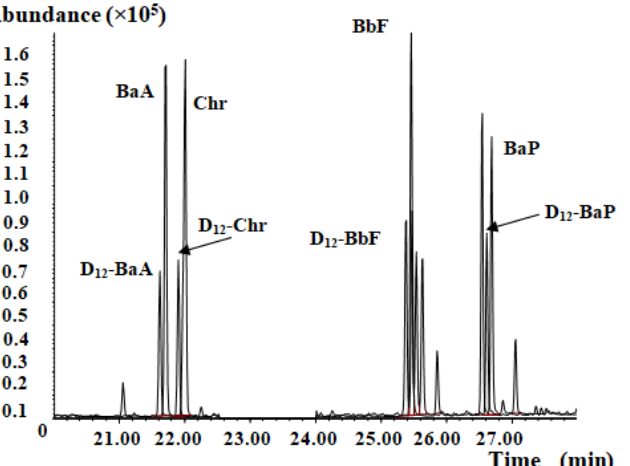
Figure 4. Representative mass chromatogram for a traditional Chinese medicine extract.